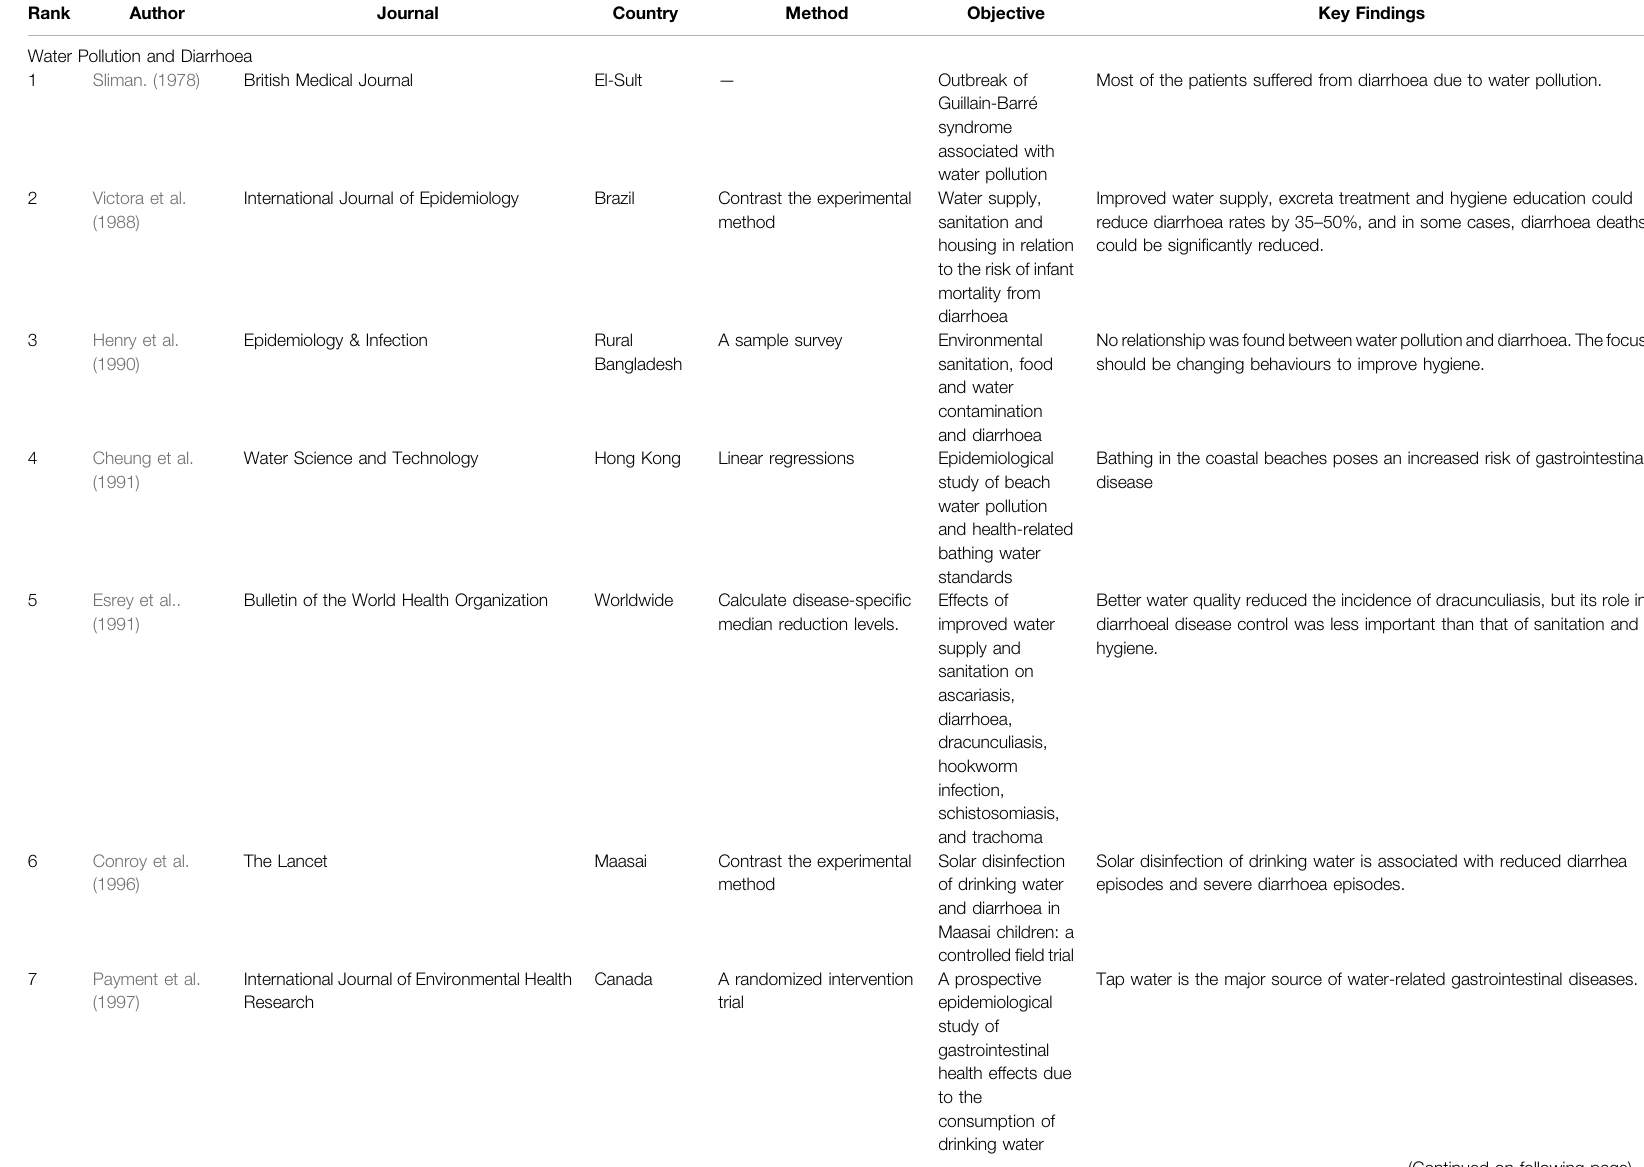
TABLE 1 | Major studies on the relationship between water pollution and